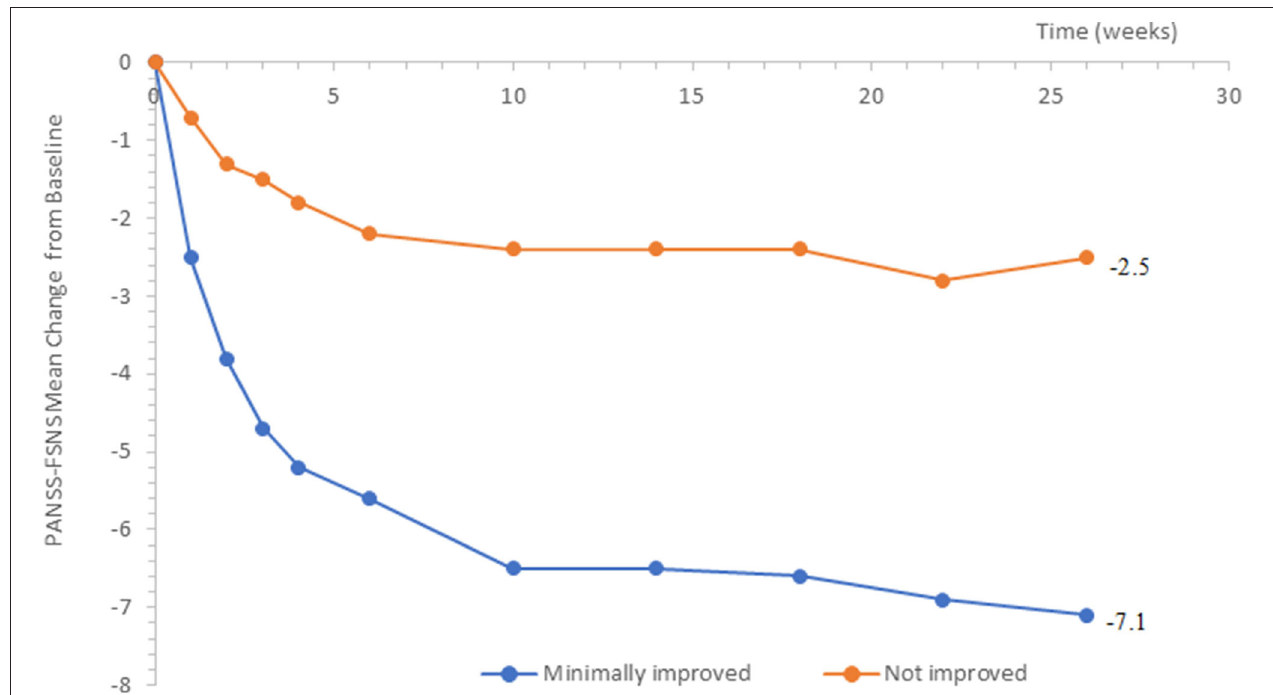
FIGURE 1 | Change from baseline in PANSS-FSNS (Positive- and Negative Syndrome Scale—Factor Score for Negative Symptoms) as a function of minimal change vs. no change.